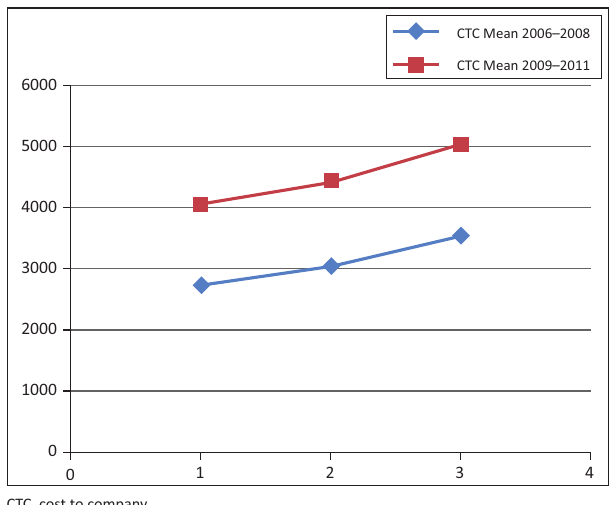
TABLE 8: Correlation and r 2 table for company financial performance and guaranteed cost to